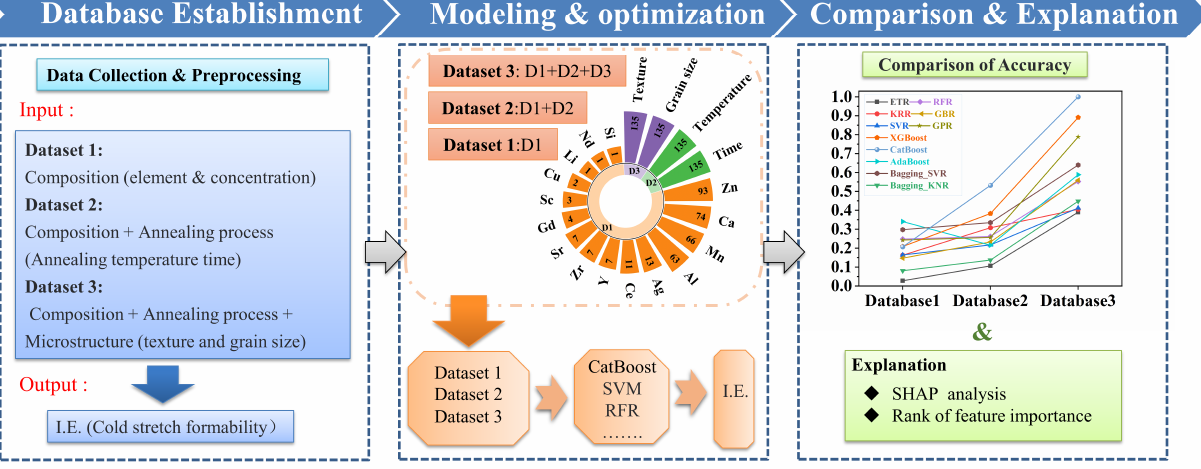
Figure 1. The detailed workflow about the important contribution of formability descriptors on cold stretch formability of Mg sheet alloy in this work via machine learning and SHAP methods.